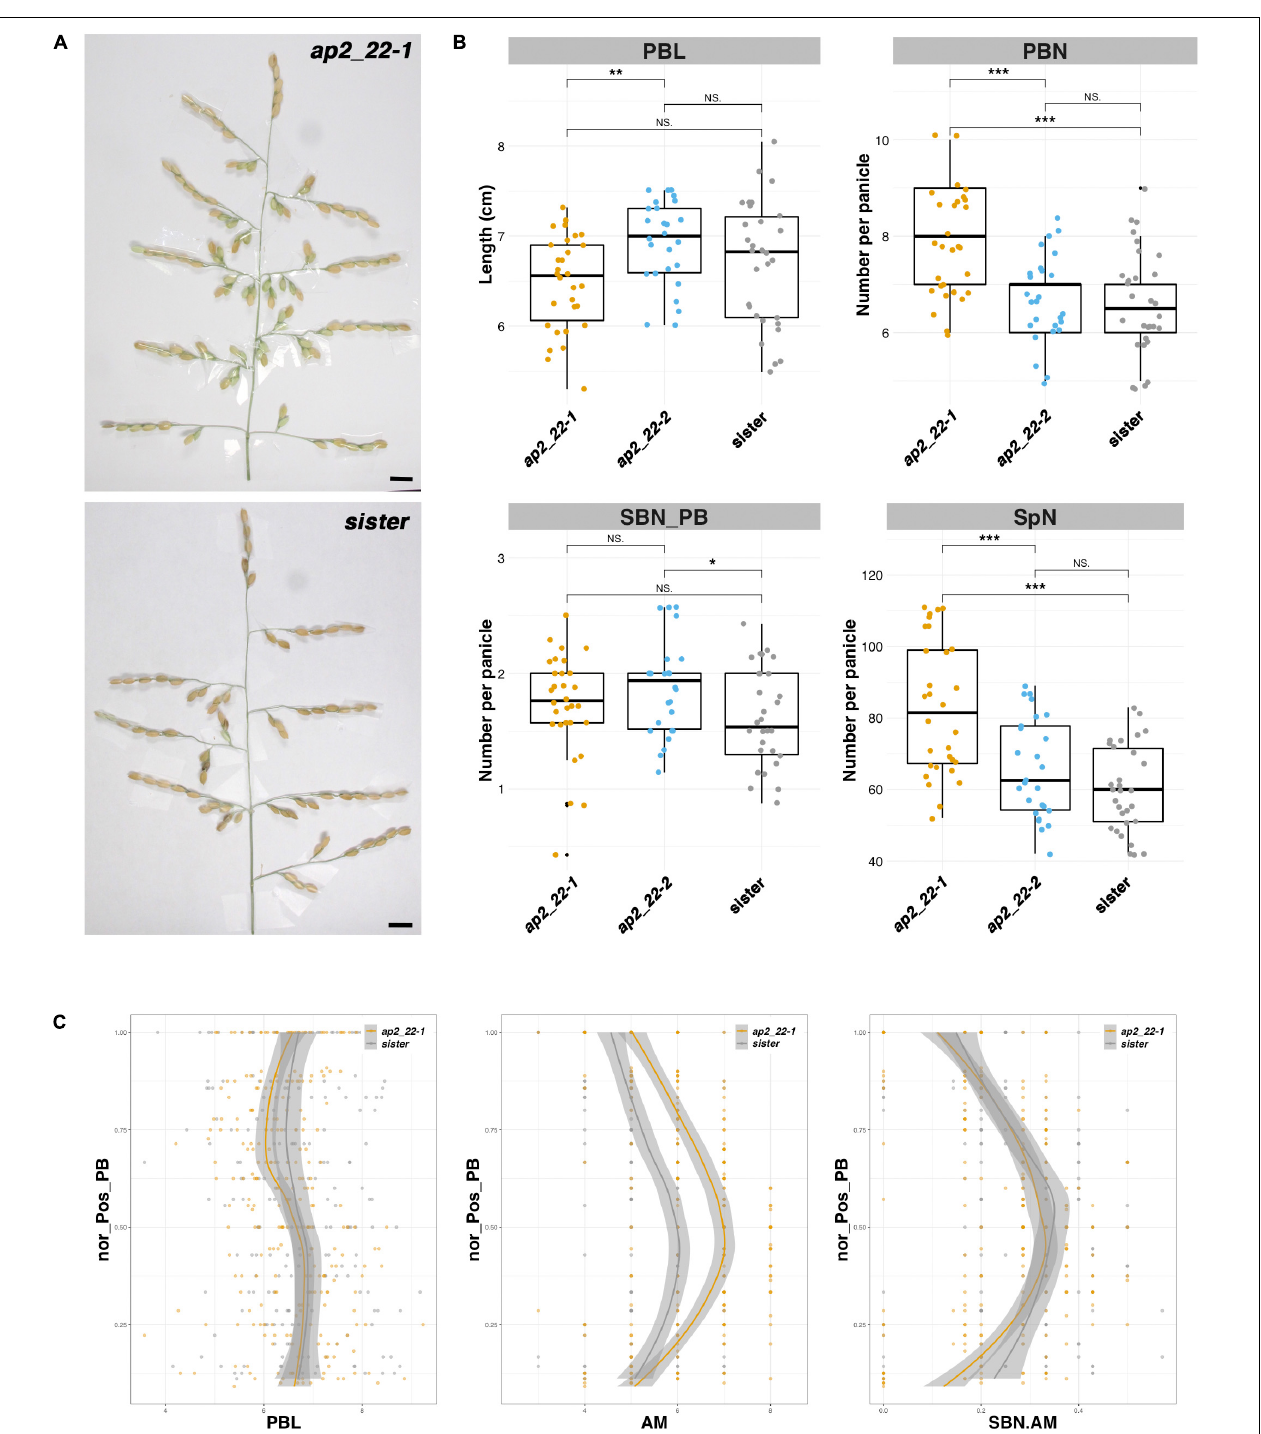
FIGURE 5 | Panicle phenotype of the ap2/erebp22 mutant. (A) Mature panicles from the CRISPR-Cas9-derived ap2_22-1 line and a sister (i.e., transgenic plant without mutation). Scale bar: 1 cm. (B) Box plots with individual dots indicating the average primary branch length (PBL), the number of primary branches (PBN), the ratio between secondary branch number and PBN (SBN_PB), and the spikelet number (SpN) per panicle of the CRISPR-Cas9-derived lines, in comparison with sister plants. Individual dots in box plots correspond to average values from the three main panicles per plant. Statistical significance ( t -test p -values) between the two lines or parents for the two panicle morphological traits is indicated as follows: NS if the test is non-significant; * p -values < 0.05; ** < 0.01; *** < 0.001. (C) Plots of normalized position of primary branch (Nor_pos_PB) against PBL, axillary meristem number per PB (AM), and the ratio of SBN vs. AM per PB (SBN.AM). Only the values for the ap2_22-1 line were considered as being significantly different from the sister